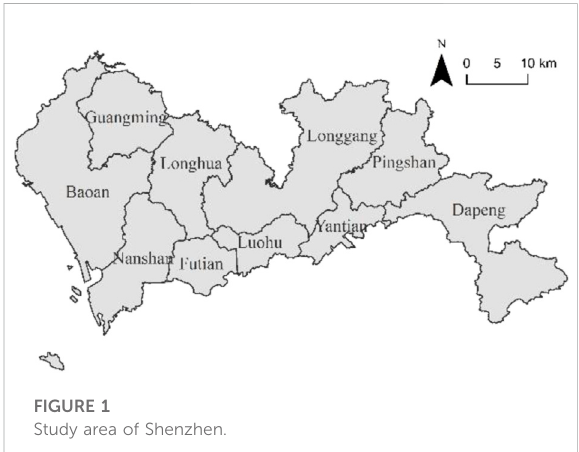
FIGURE 1 Study area of Shenzhen.